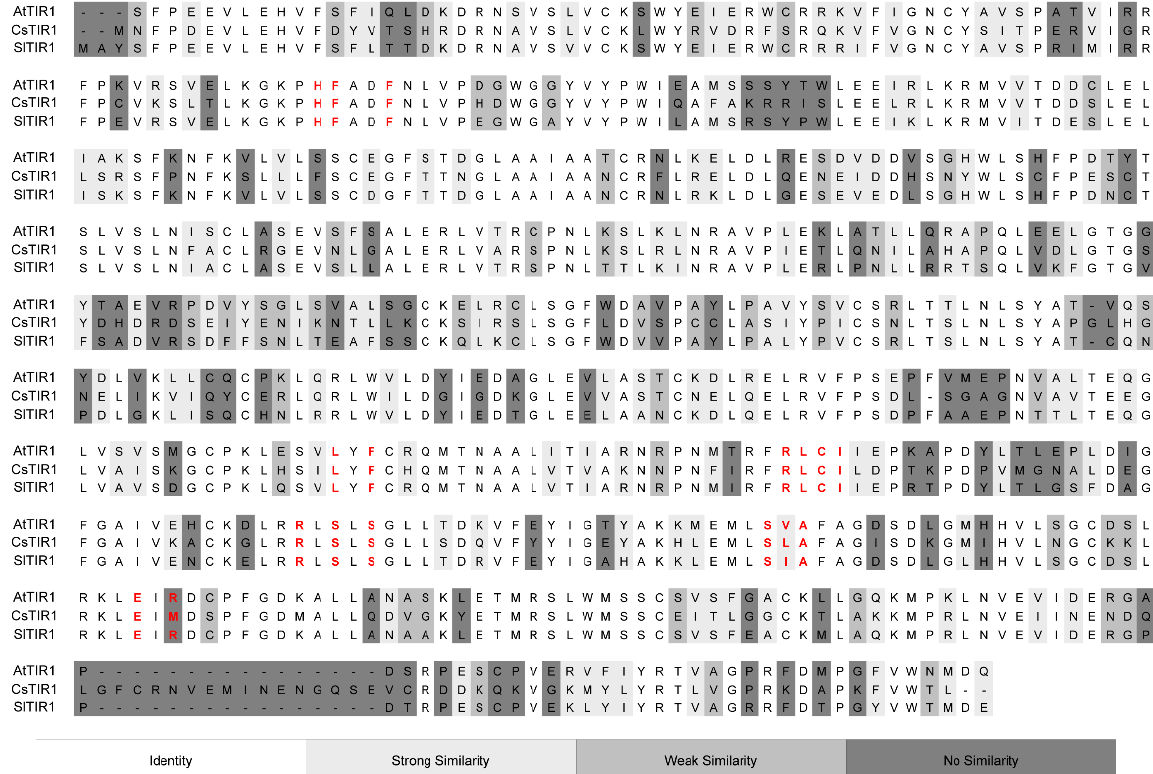
8 of 16 Figure 5. Relative contributions of various intermolecular contacts to the Hirshfeld surface area in HEA- p NBA and HEA- p ABA discussed in detail in the text. 2.4. Homology Modeling and Ligand Docking In order to find an explanation for the contrasting activities of two similar organic salts we proceeded to analyze the interaction of the active component with the auxinic receptor TIR1. As the three-dimensional structures of the TIR1 from cucumber (CsTIR1) and tomato (SlTIR1) have not yet been solved, we used homology modeling to obtain accurate 3D models of these proteins. Homology modeling is a computational method extensively used to predict a 3D structure of a protein from its amino acid sequence re- lying on the paradigm that similar sequences fold into identical structures. The closest “relative” of CsTIR1 and SlTIR1 with a known 3D structure is the X-ray structure of TIR1 isolated from Arabidopsis (AtTIR1). Therefore we used AtTIR1 to generate 3D models of